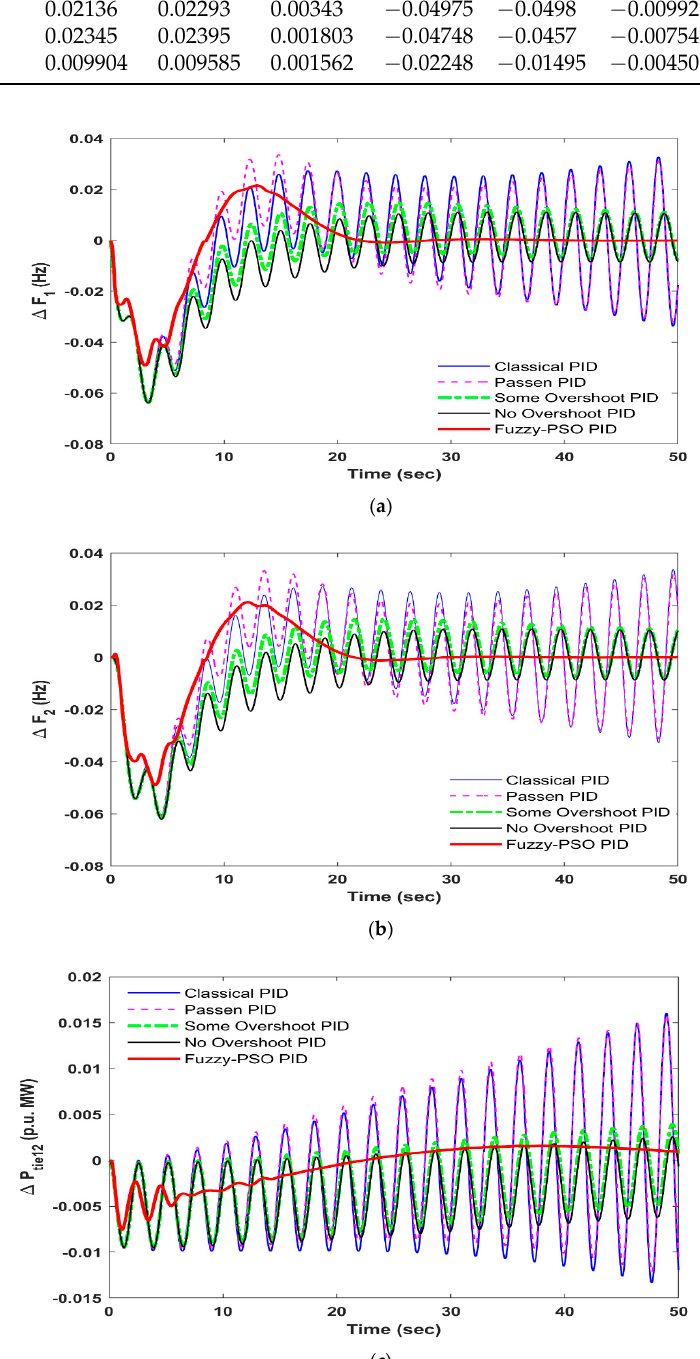
Figure 8. ( a – c ) LFC results in 1% load alteration in region-1.